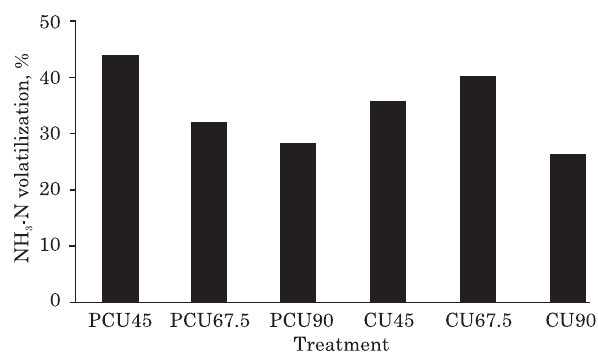
Figure 3. Percentage of ammonia (NH 3 -N) in relation to the total N applied as maize topdressing. PCU 45: Polymer-coated urea (45 kg ha -1 N); PCU 67.5: Coated urea (67.5 kg ha -1 N); PCU 90: Coated urea (90 kg ha -1 N); CU 45: Conventional urea (450 kg ha -1 N); CU 67.5: Conventional urea (67.5 kg ha -1 N); and CU 90: Conventional urea (90 kg ha -1